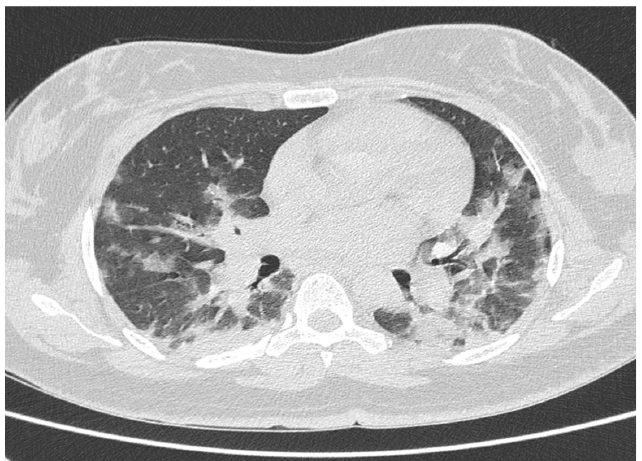
Figure 1. CT scan of a 66-year-old unvaccinated woman with COVID-19 interstitial pneumonia. CO-RADS 4, confirmed by molecular swab; RNSA CT severity score of 22 points. The patient was admitted to the subintensive care unit.